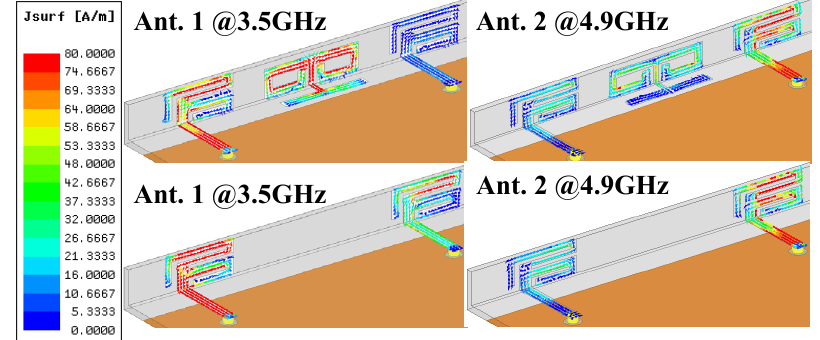
Figure 4. Current distribution at two resonant modes when DB1 is utilized or not.